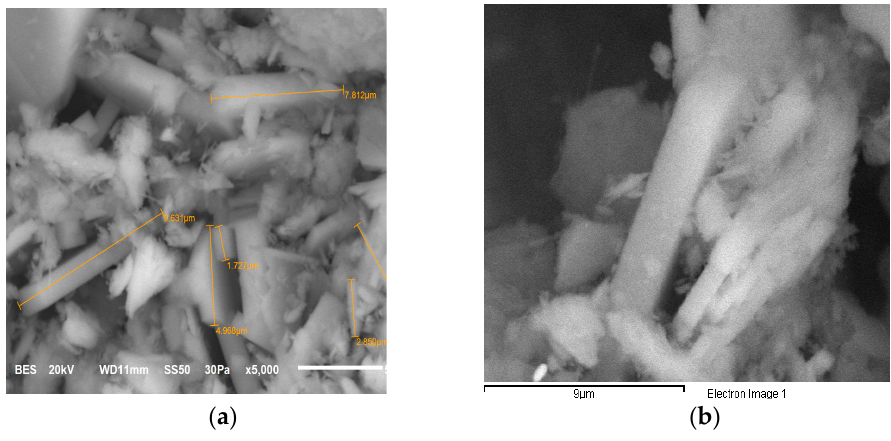
Figure 4. SEM micrographs of clinoptilolite zeolite CLINA: ( a ) ×5000; ( b ) ×1000.